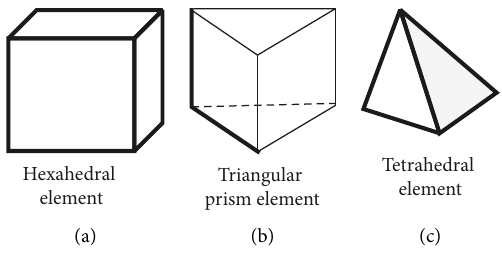
Figure 2: The brittle material unit (a) is a hexahedral unit, (b) is a triangular prism unit, and (c) is a tetrahedral unit.